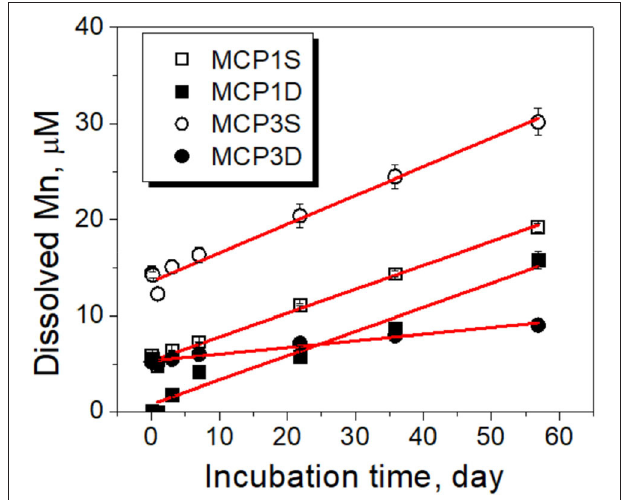
FIGURE 5 | Kinetics of dissolved Mn over time during sediment incubation experiments. Black symbols are the experimental data, and red lines are the fitted results with the zero rate (Equation 2). The error bars represent one standard deviation from duplicate